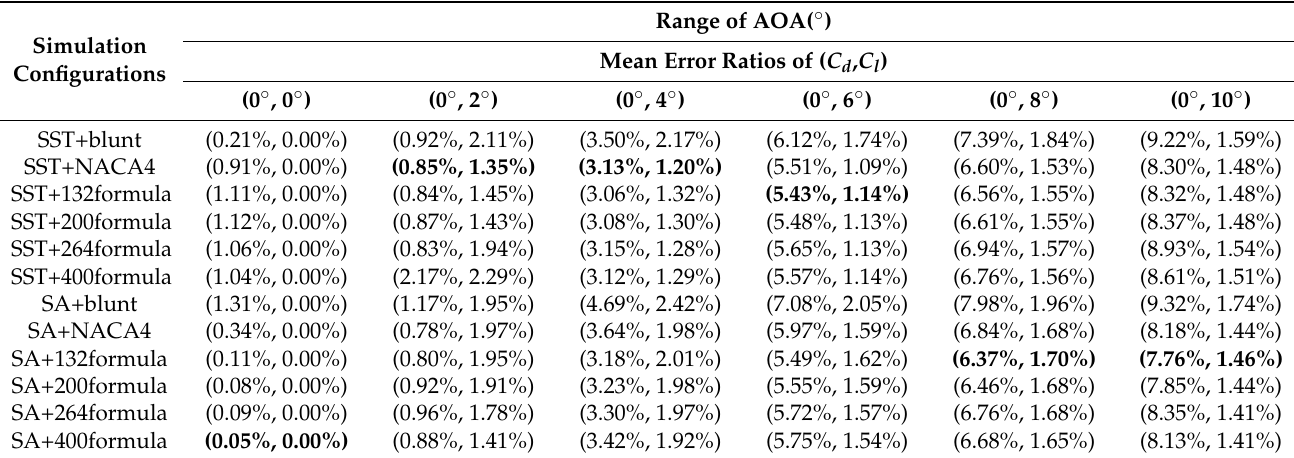
Table 15. The mean error ratios of C d and C l of 16 m far-field distance.